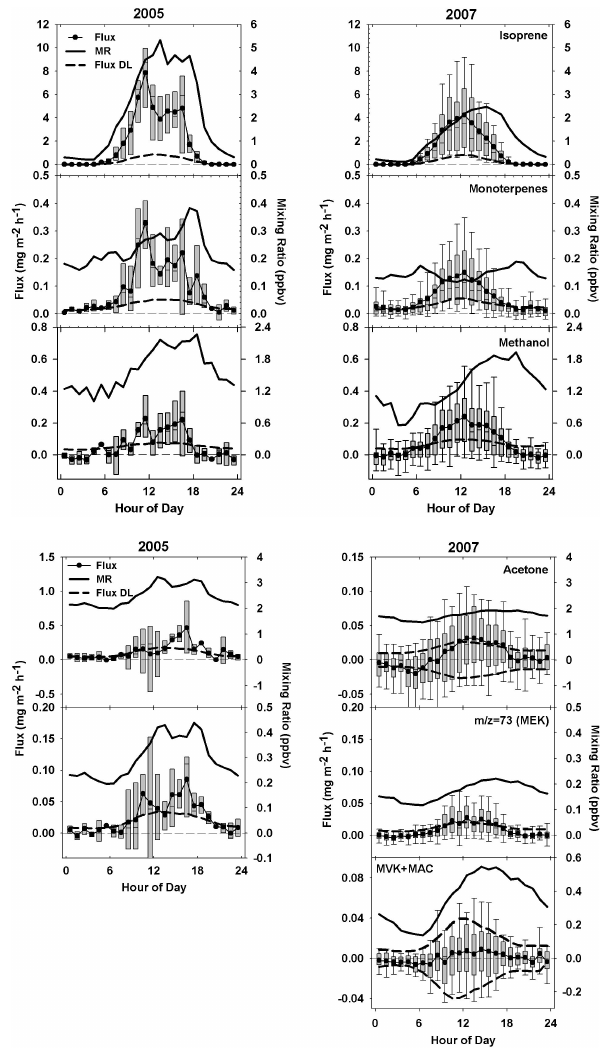
Fig. 5. Diel cycles of mean fluxes (filled circles) and mixing ra- tios for a range of BVOCs during 2005 (left) and 2007 (right). The box and whisker plots show the median (horizontal line), upper and lower quartiles (shaded boxes), and highest and lowest deciles (error bars) of the individual measurements. Due to the small number of measurements in 2005, only the quartiles can be determined. The flux detection limits for each species, calculated from the covari- ance far away from the true lag as described in the text, are also shown. The vertical axes are the same in both years for all species except acetone, for which the y-axis is expanded by a factor of 10 in 2005 relative to 2007. The mean temperature and PPFD for the time period of the observations are shown in Fig. 6.